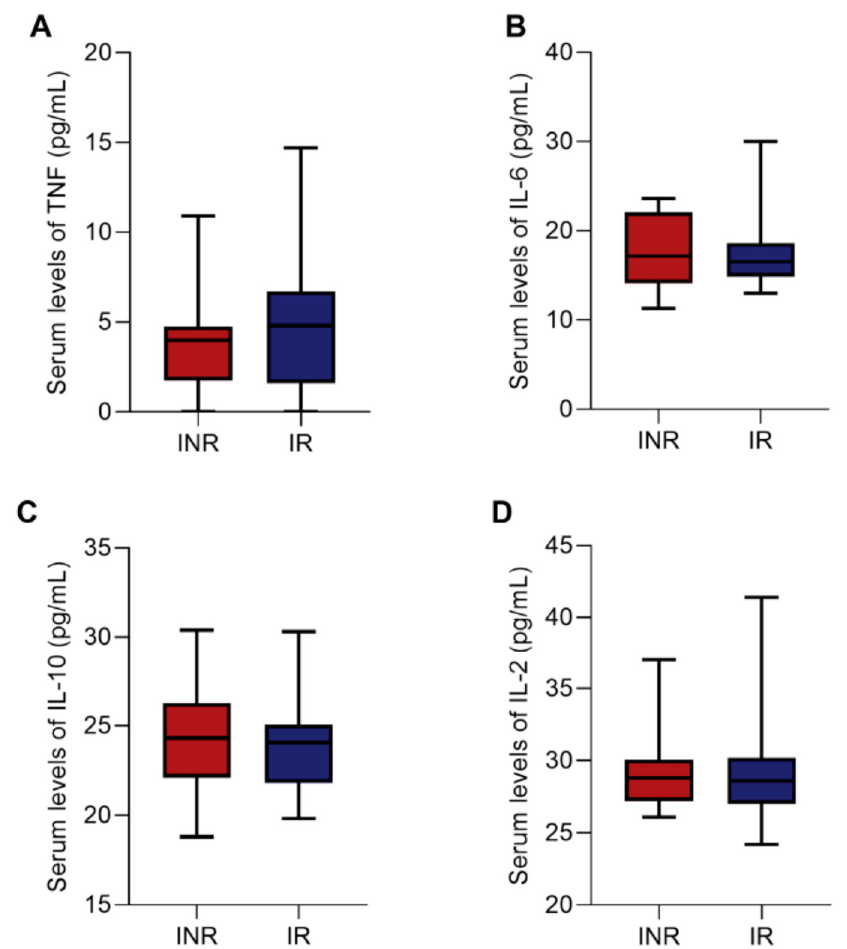
Figure 6. Box plots showing the plasma levels of TNF ( A ), IL-6 ( B ), IL-10 ( C ), and IL-2 ( D ) cytokines between the INR and IR groups. Medians and interquartile range are shown. Mann–Whitney test was used to compare INR and IR groups. INR—immunological non-responders. IR—immunological responders.